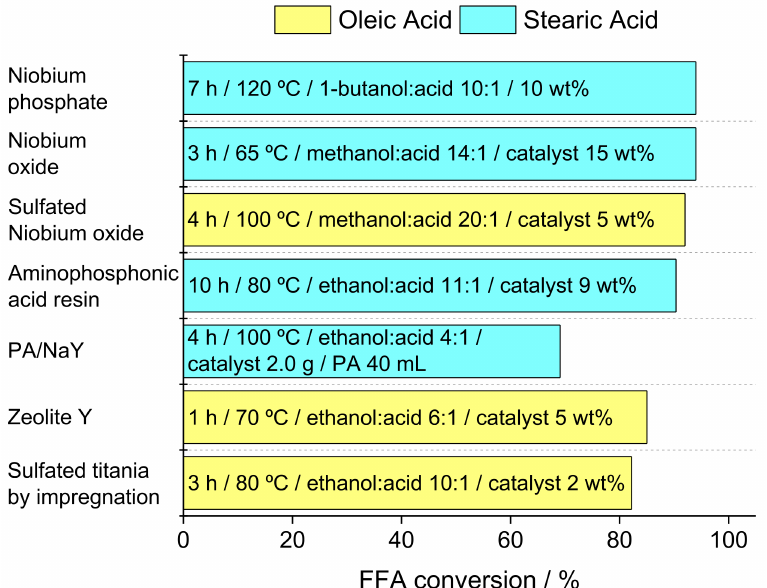
Figure 6. Comparison of conversions achieved in oleic and stearic esterification reactions over different catalysts acid solid (adapted from